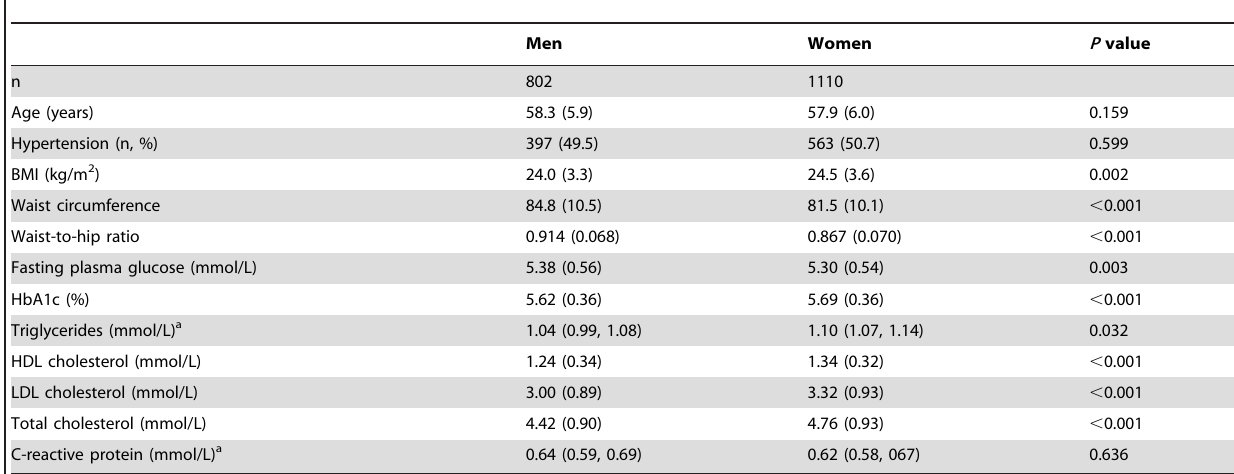
Table 1. Baseline characteristics of the followed participants without diabetes in the 6-year follow-up cohort in Beijing and Shanghai, China,